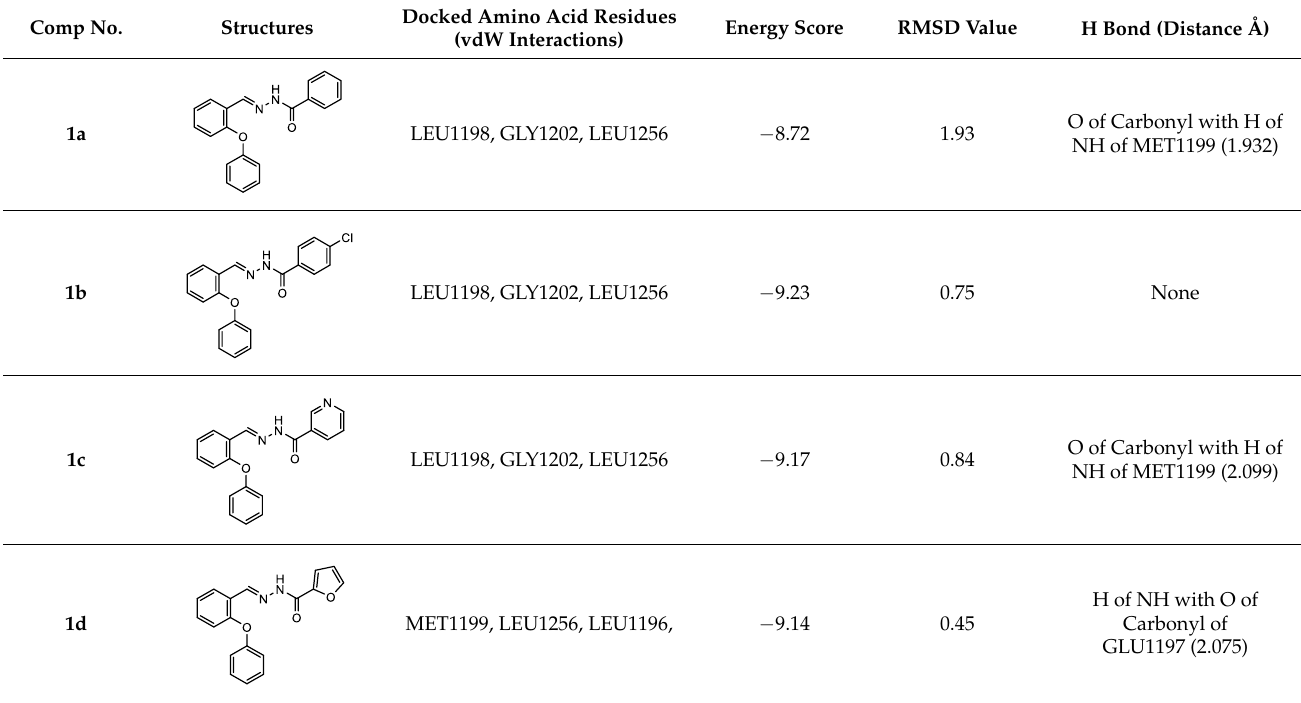
Table 3. Docking results of human anaplastic lymphoma kinase (2XP2).